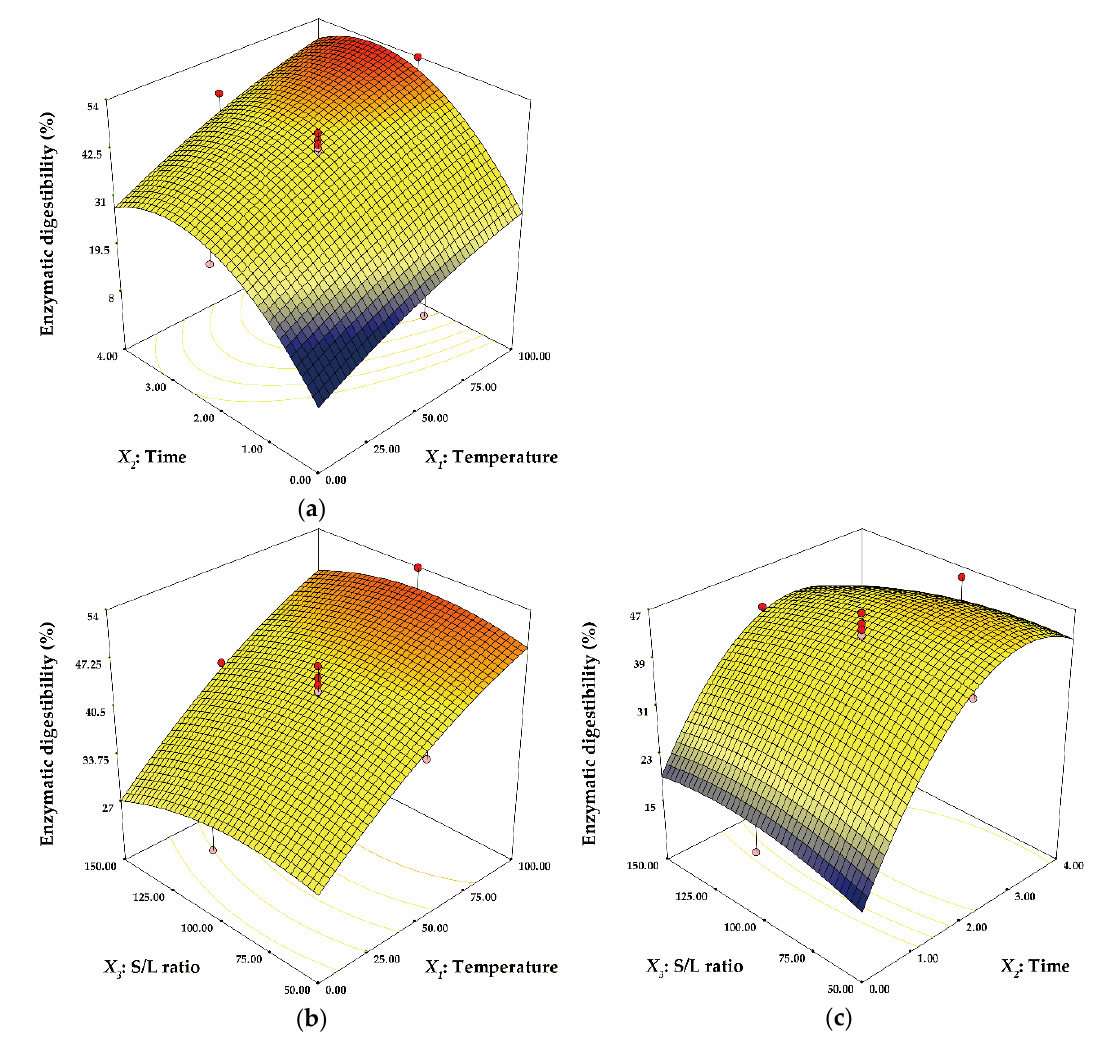
Figure 3. The three-dimensional response surface plot for the interactive effect of temperature and time ( a ), temperature and S/L ratio ( b ) and time and S/L ratio ( c ) on enzymatic digestibility (ED).